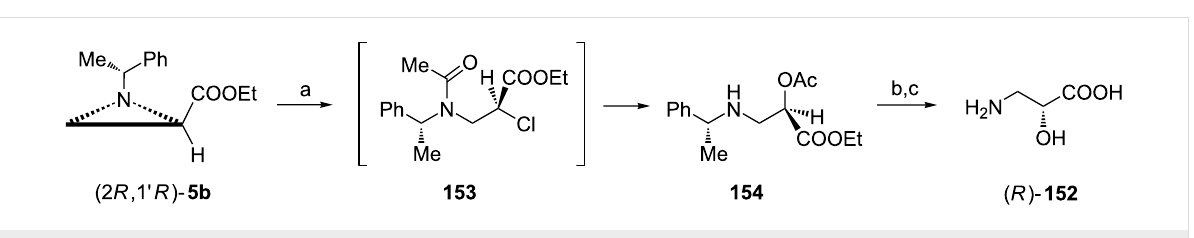
Scheme 39: Synthesis of (+)-isoserine ( R )- 152 . Reagents and conditions: a) AcCl, MeCN, rt, 0.5 h then Na 2 CO 3 , CH 2 Cl 2 /H 2 O, rt; b) H 2 , Pd/C,